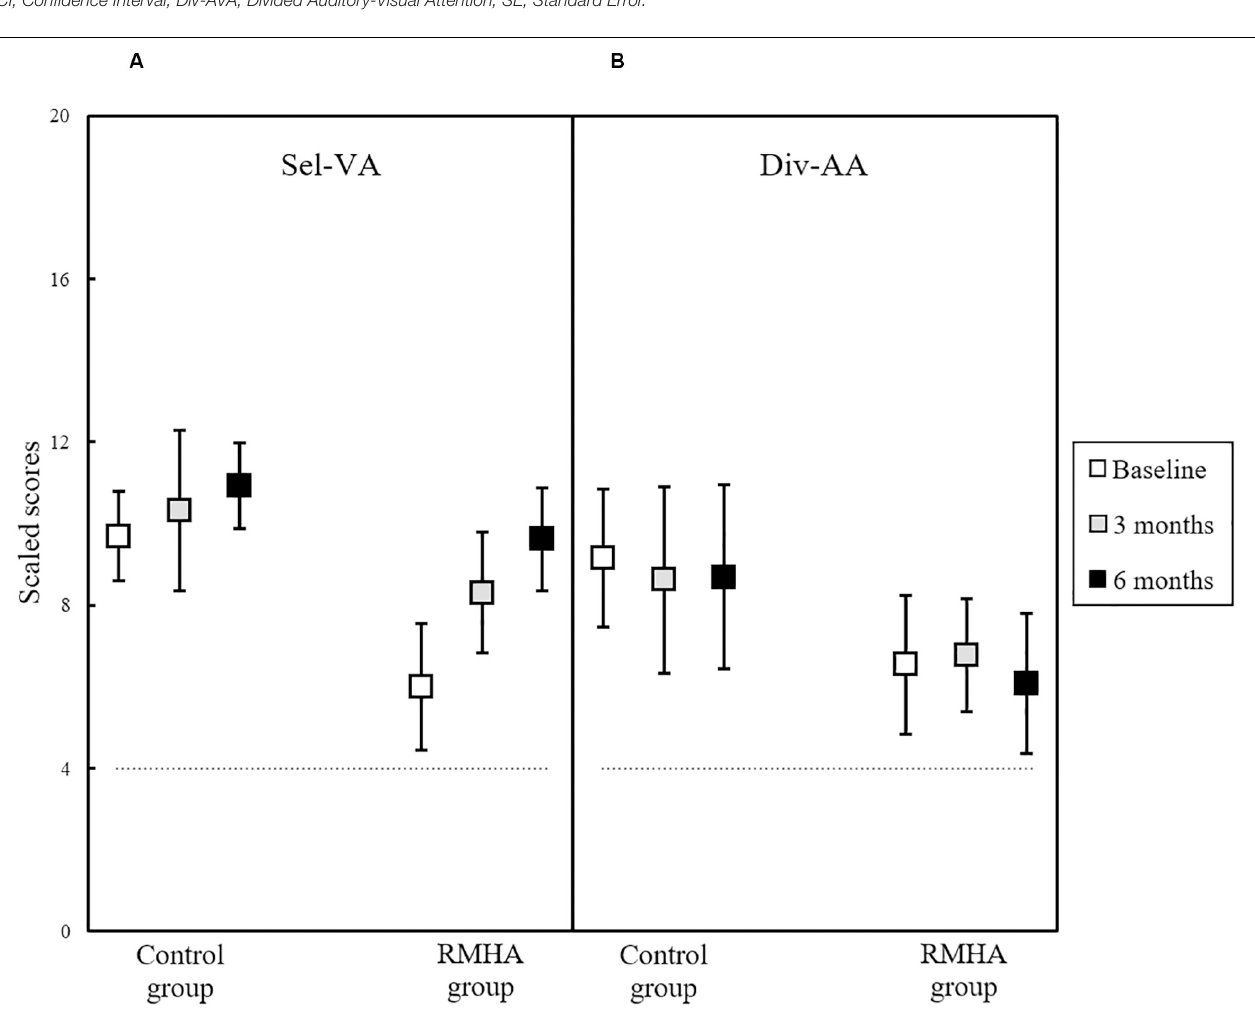
FIGURE 6 | Plots of mean scaled scores in (A) the TEACh Sel-VA subtest, and (B) the TEACh Div-AA subtest, for 13 controls and 13 RMHA children, at baseline, 3 and 6 months. Error bars represent a 95% CI of the mean. The horizontal dotted line indicates the cut-off for what is considered abnormal performance (i.e.,